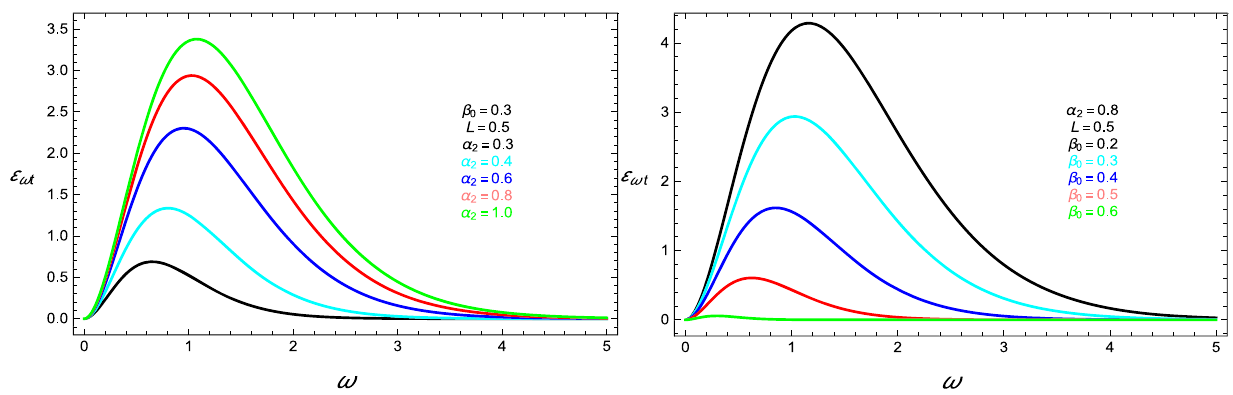
Fig. 12 Plots for the rate of energy emission varying with the frequency with fixed value of β 0 = 0 . 3 and α 2 = ( 0 . 3 , 0 . 4 , 0 . 6 0 . 8 1 . 0 ) {left} and α = 0 . 8 and β = ( 0 . 2 , 0 . 3 , 0 . 4 , 0 . 5 , 0 . 6 ) 2 0